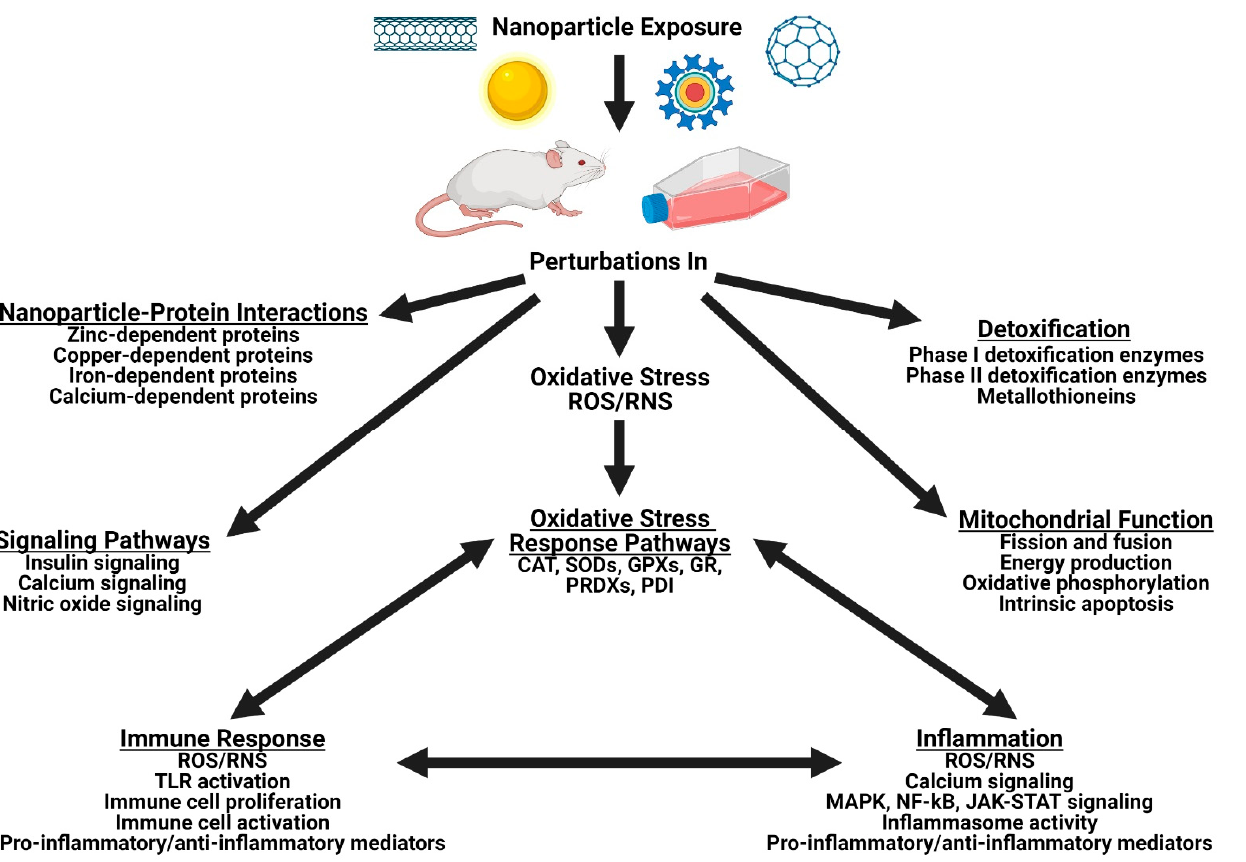
Figure 1. Nanoparticle exposure on biological systems may induce oxidative stress and affect the proteins involved in the stress response pathways (such as CAT, SODs, GPXs, GR, PRDXs, and PDI), the immune response (through TLR activation, immune cell proliferation and activation, and the production of inflammatory mediators), inflammatory responses (through inflammasome activity, the production of inflammatory mediators, and calcium, MAPK, KF- κ B, and JAK-STAT signaling), mitochondrial function (including mitochondrial fission and fusion, amount of ATP produced, oxidative phosphorylation, and intrinsic apoptosis), biological signaling pathways (such as insulin, calcium, and nitric oxide signaling), detoxification (involving the Phase I and II detoxification